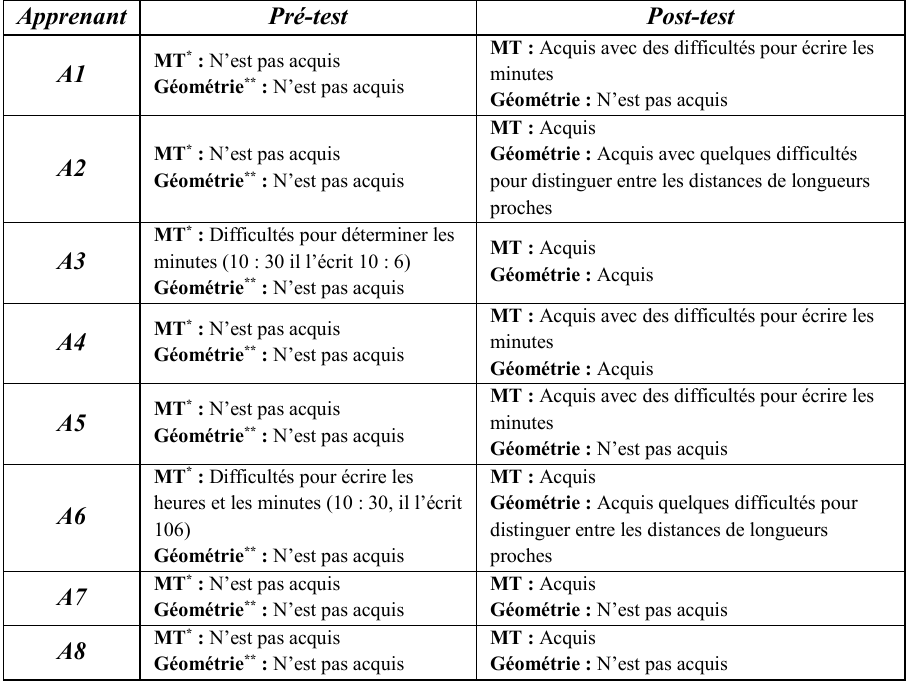
Tableau 4 : Les résultats du pré et du post-test de l’échantillon expérimental ( MT : Distinguer entre les minutes et les heures ; Géométrie : Distinguer entre les distances longues et